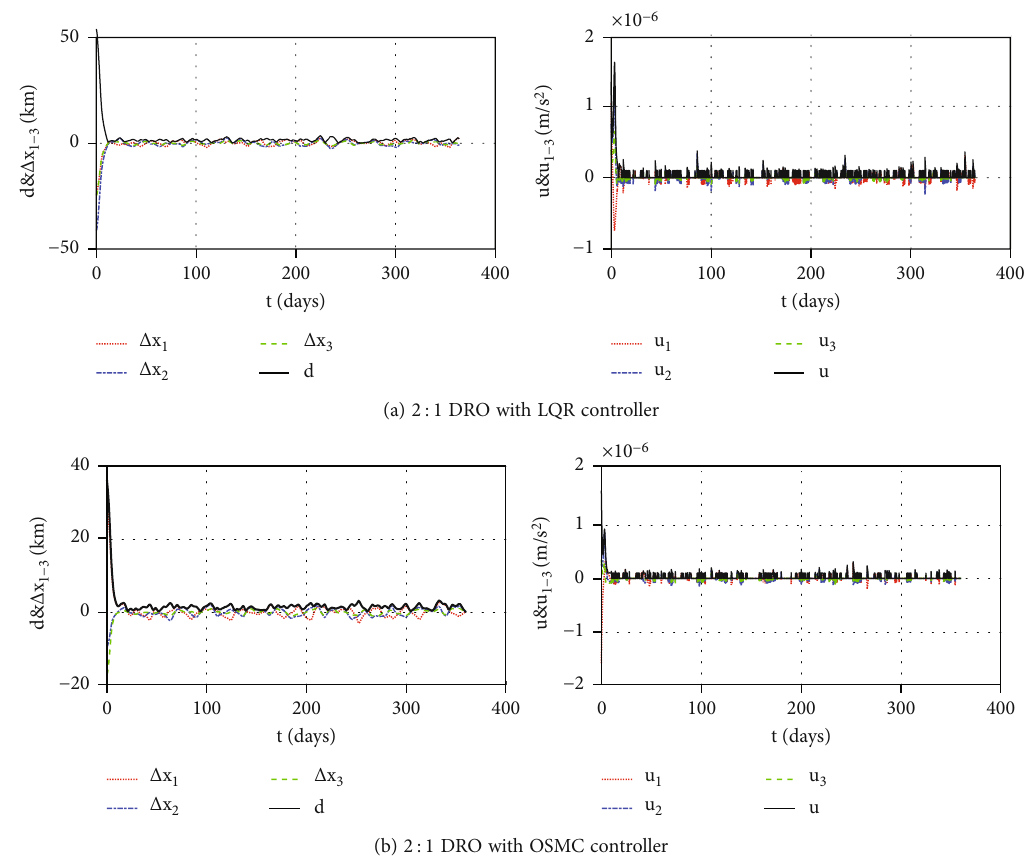
Figure 9: The station-keeping simulations of the 2: 1 DRO under practical